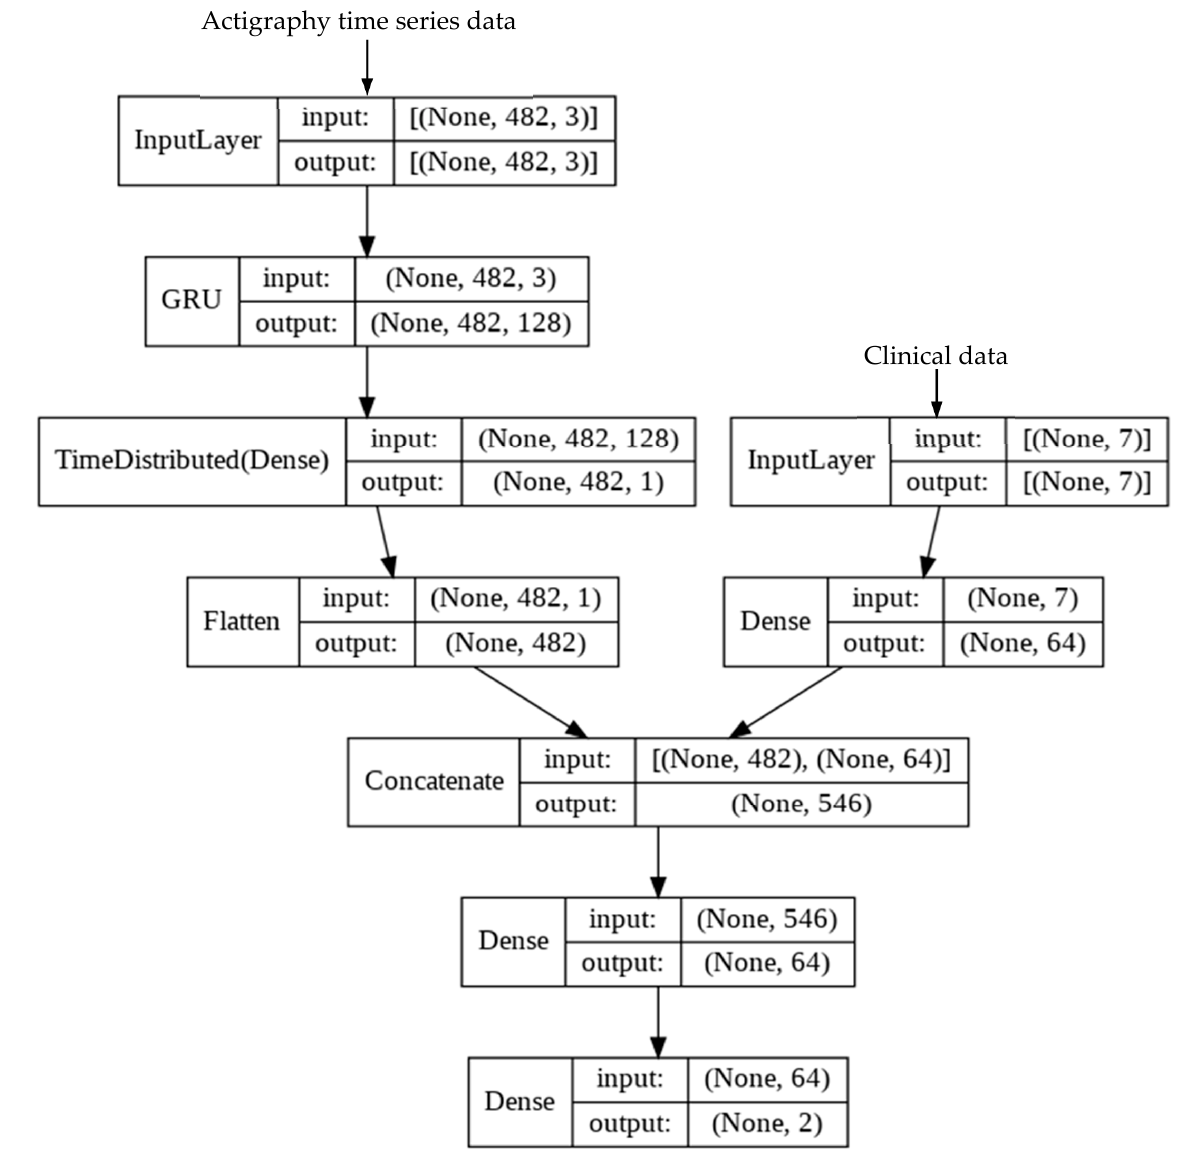
Figure A9. Configuration of GRU model used for experiment with time series data and clinical data.